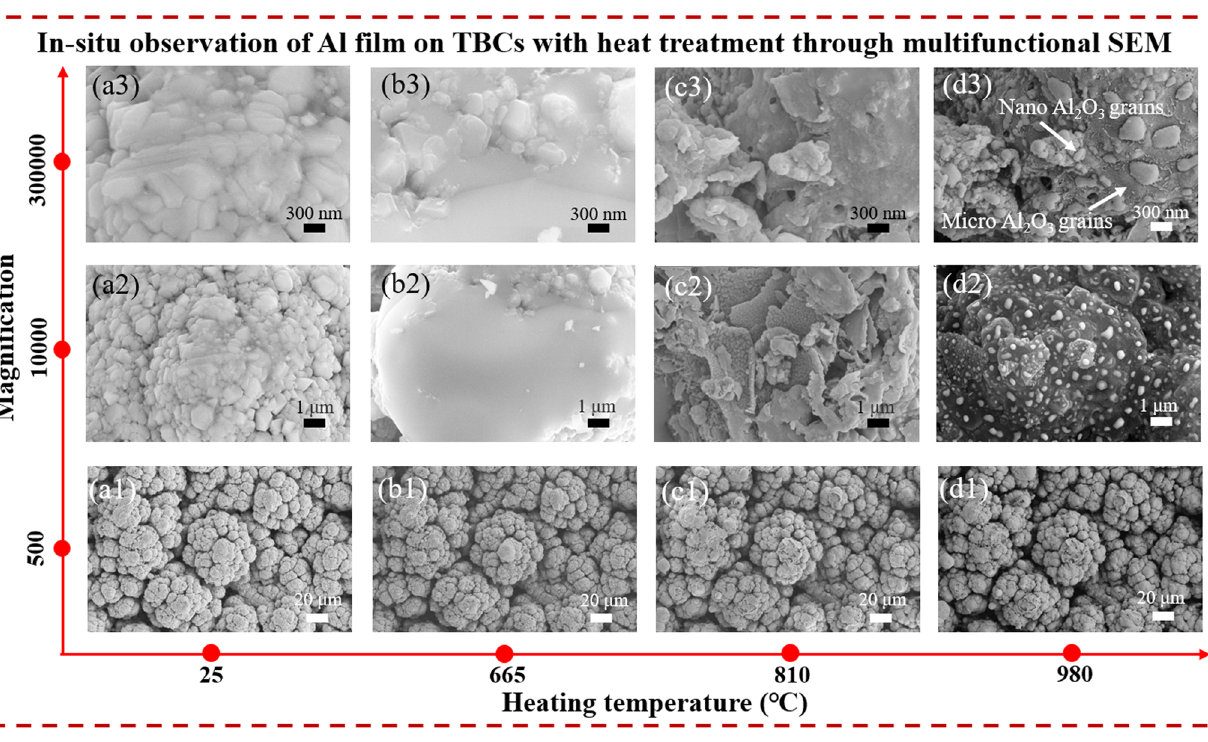
Fig. 4 In situ multifunctional SEM observation of Al fi lm on PS-PVD 7YSZ TBCs with heat treatment. a1 – a3 Surface microstructure at 25 °C. b1 – b3 Surface microstructure at 665 °C. c1 – c3 Surface microstructure at 810 °C. d1 – d3 Surface microstructure at 980